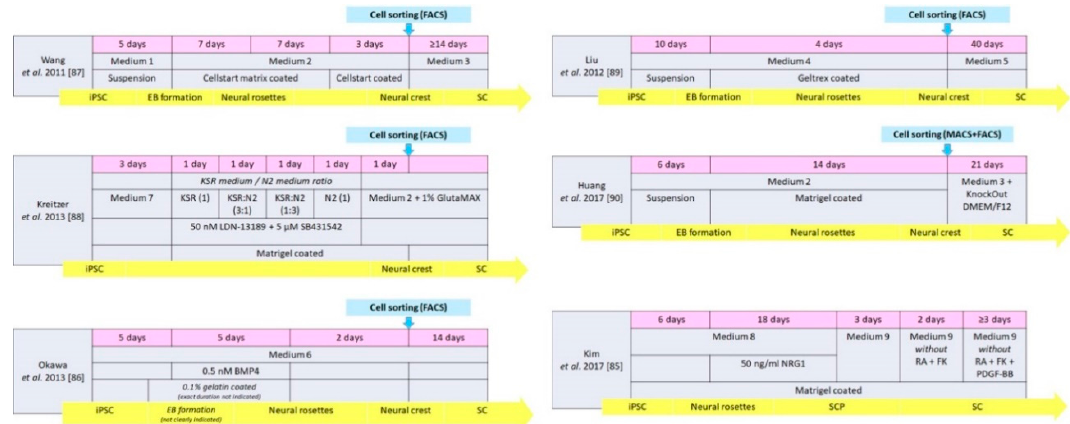
Figure 1. Timing, conditions, and stages for the di ff erentiation of induced pluripotent stem cells (iPSC) to Schwann cells (SC) according to di ff erent protocols. Pink bar indicates the length of time for each stage (the media used are summarized in line 2, with more information on the components provided in Table 1). Whether the cells are cultured in suspension or on a coated surface, as well as the type of coating used, can be seen in the bottom gray line. The yellow bar indicates the cells identified to be present at each stage as defined in the respective protocols. If any cell sorting is included, this is shown by the blue box and arrow. Abbreviations: BMP4: bone morphogenetic protein 4. DMEM / F12: Dulbecco’s modified Eagle’s medium / Nutrient Mixture F-12 Ham. EB: embryoid bodies. FK: forskolin. KSR and N2 medium according to Kreitzer et al. [88] , see Table 1. NRG1: neuregulin 1. PDGF-BB: platelet-derived growth factor two B subunits. RA: retinoic acid. SCP: Schwann cell precursors.